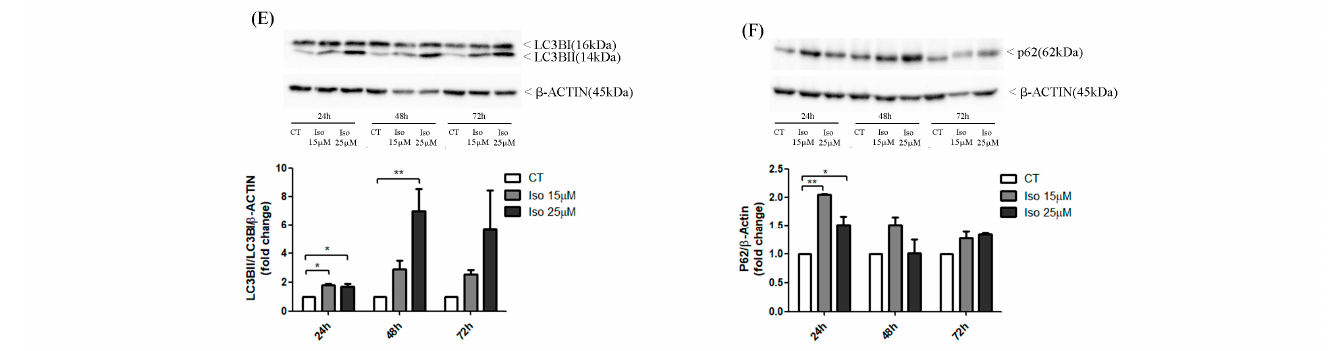
Figure 4. ( A ) Human apoptosis signaling pathway array in U87MG cells control and treated. ( B ) TUNEL assay in U87MG treated with Iso 15 and 25 µM for 48 h: isoginkgetin 25 µM causes a DNA fragmentation after 48h of treatment. ( C , D ). Western blot analysis of PARP and Caspase-3 in U87MG cells treated with Iso 15 and 25 µM for 24, 48 and 72 h: in the treated cells compared to the control there is an increase of cleaved PARP ( C ) and cleaved caspase-3 ( D ) at both concentrations of Iso and at all times. ( E , F ). Values are the means ± SEM of three individual experiments. One-way ANOVA test, Bonferroni’s multiple comparison test, p values < 0.05. According to GraphPad Prism, * p value 0.01 to 0.05 (significant), ** p value 0.001 to 0.01 (very significant).